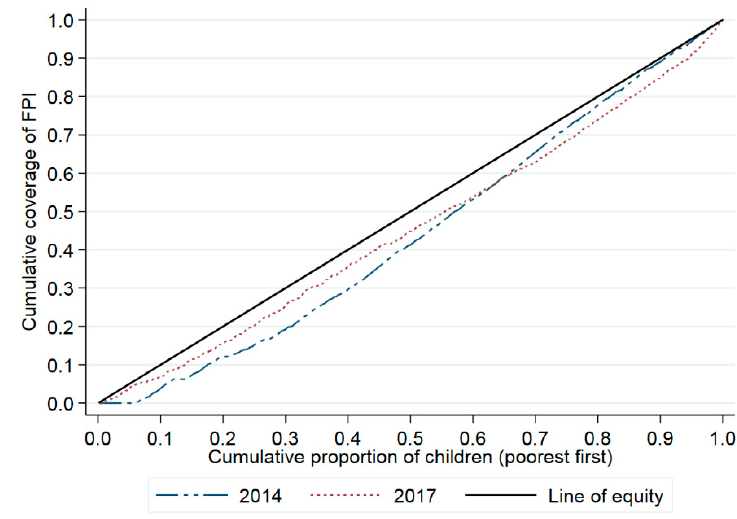
Figure 2. The concentration curve of inequality in the coverage of FPI in the 2014 and 2017 coverage surveys. Table 2. The concentration index and contributions of determinants to inequities in the coverage of FPI in the 2014 coverage